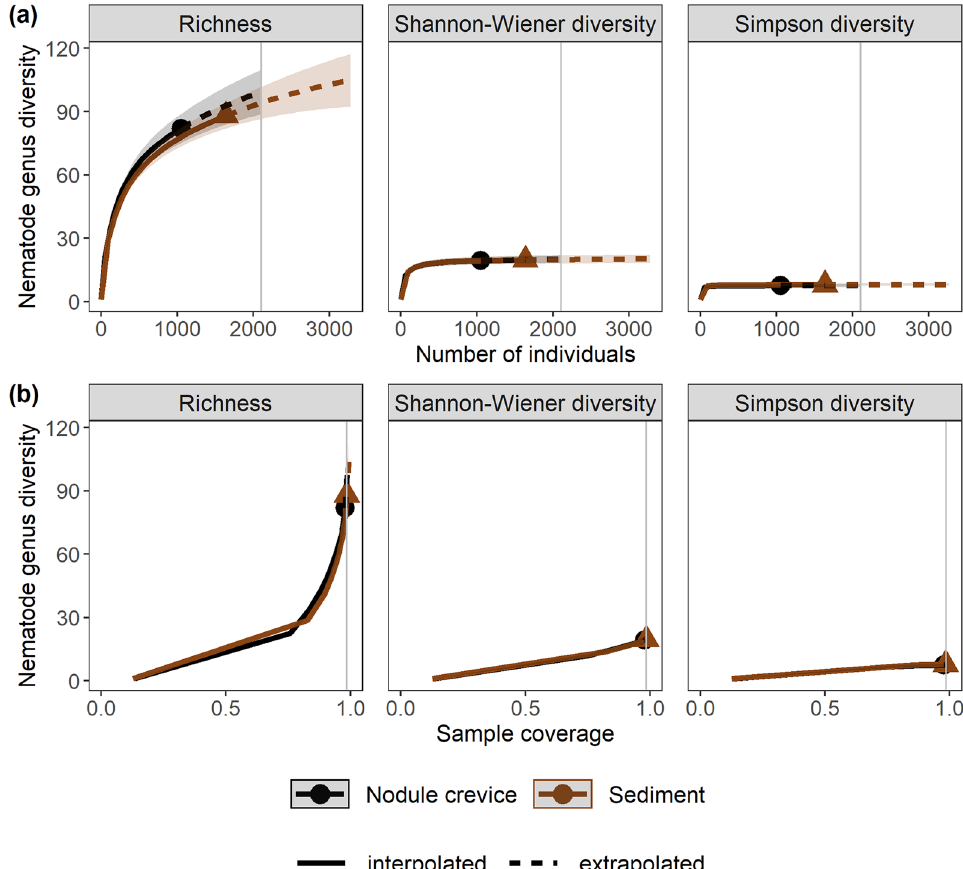
Figure 7. Nematode genus diversity in nodule crevice and sediment samples. Shown are ( a ) sample-size- and ( b ) sample coverage-based rarefaction (interpolated) and extrapolation (predicted, guided by asymptotic estimators) curves for nematode genus diversity based on abundances. The different panels show Hill numbers of orders (q) 0 (Richness), 1 (Shannon–Wiener diversity), and 2 (Simpson diversity). The vertical grey line denotes the base sample size in ( a ) and the base sample coverage in ( b ). Shaded areas represent 95% confidence